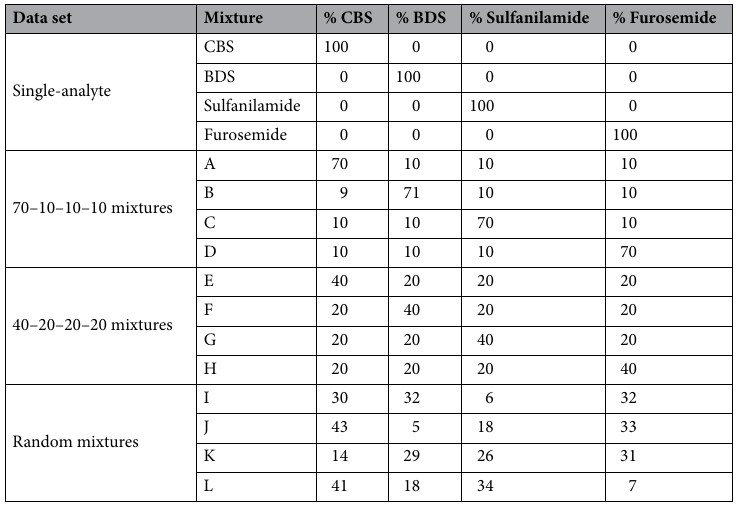
Table 1. Molar composition of the 4 single-analyte solutions and 12 mixtures used in this study. For clarity, the mixtures are regrouped in sets named according to the relative fraction of each